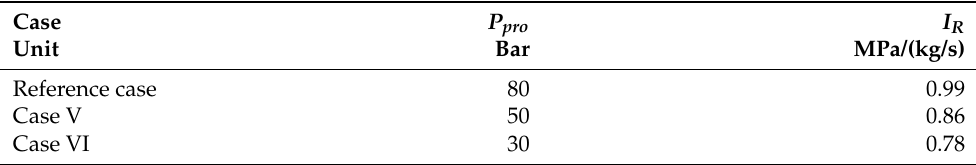
Table 6. Production pressure and flow impedance for P pro sensitivity cases